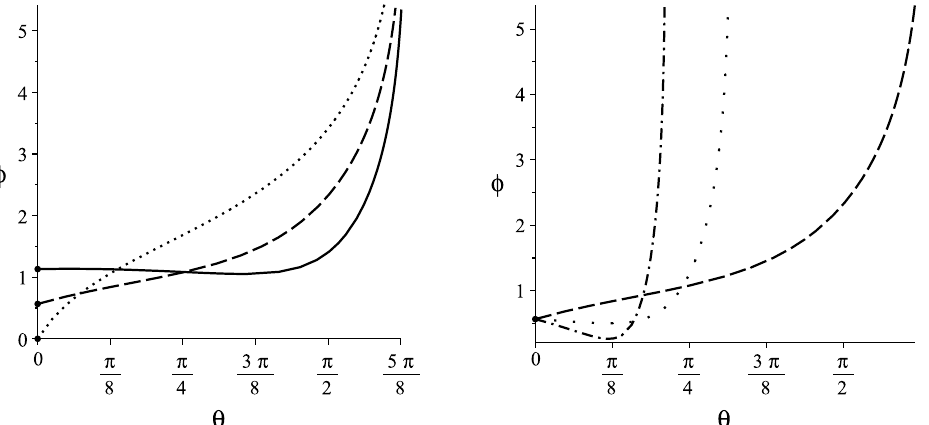
Figure 5 . Plots of ’ ( t ) for di(cid:11)erent values of C (cid:3) C (cid:3) = 1 (solid line), C (cid:3) = 1 (dashed line) and C (cid:3) 2 2 2 takes the values: C (cid:3) = 1 (dashed line), C (cid:3) 1 Note that the dashed lines on the left and right sides are the same curve.